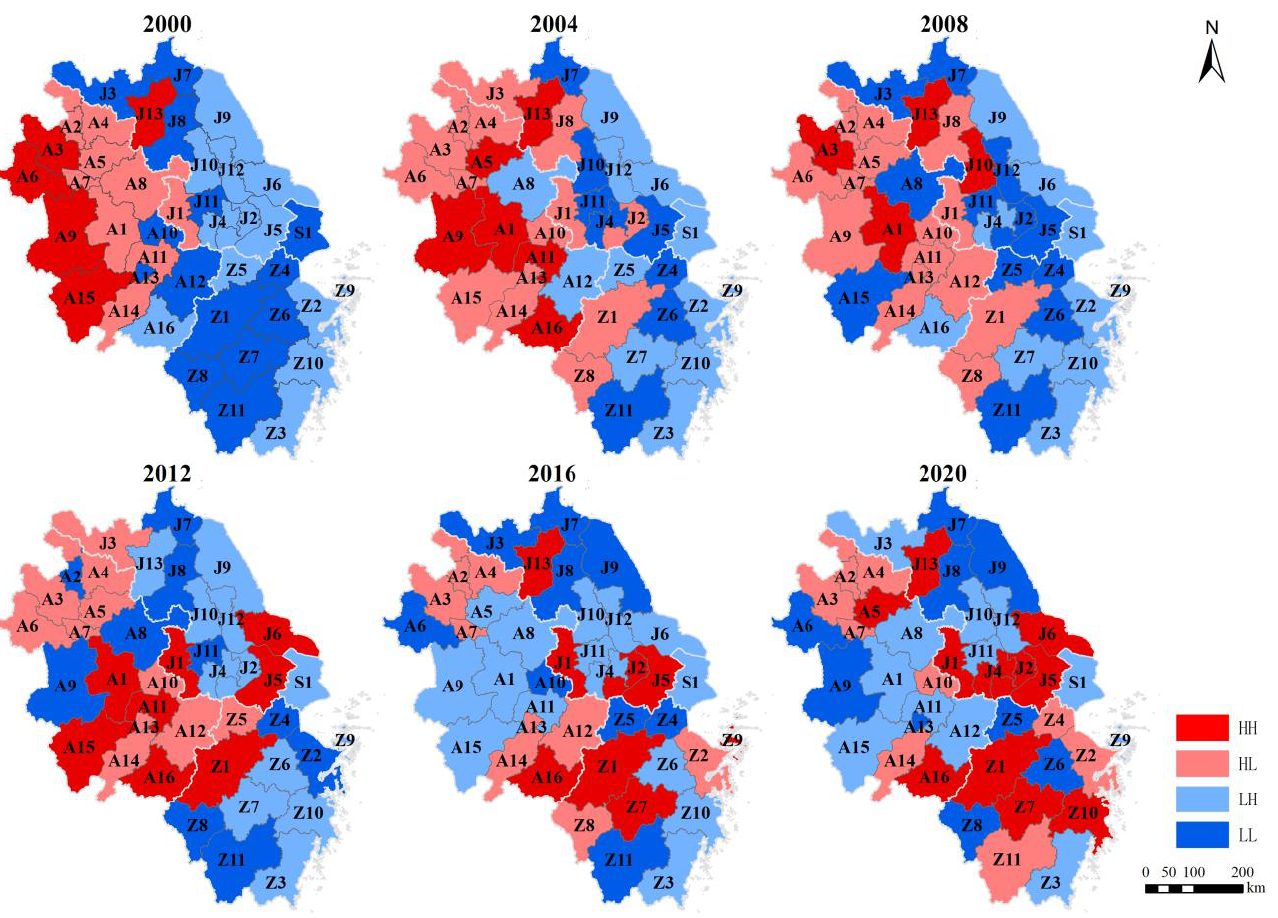
Figure 4. The spatiotemporal distribution of local government behavioral preferences.